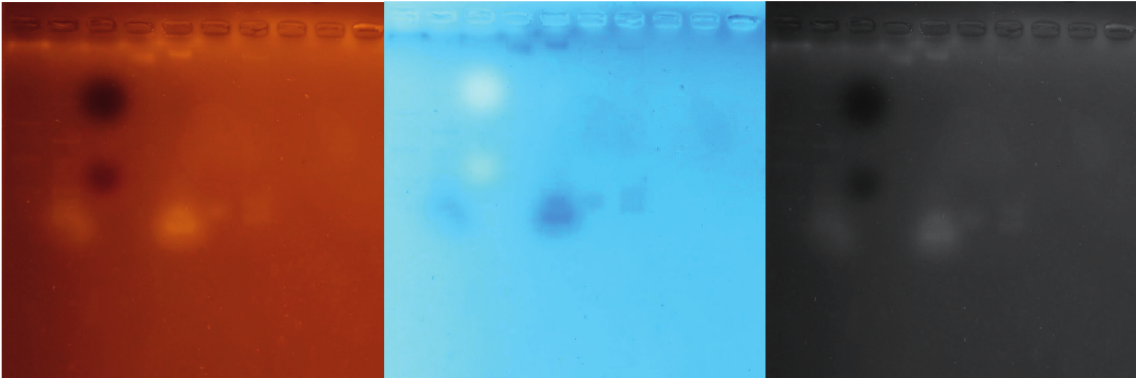
Figure 18: Gel electrophoresis of DNA fragments using coumarin 3 as a fluorescent stain